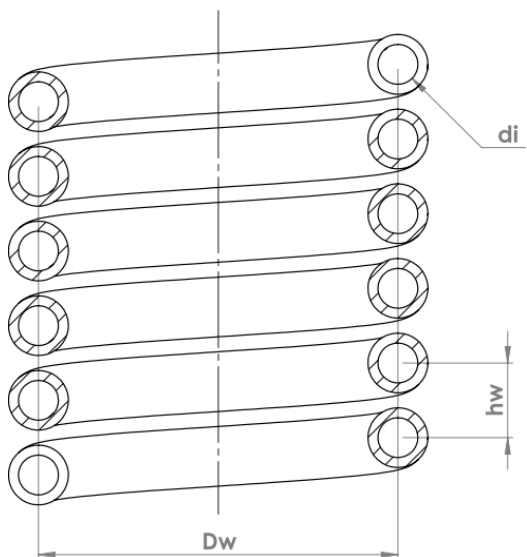
Figure 3. Outflow